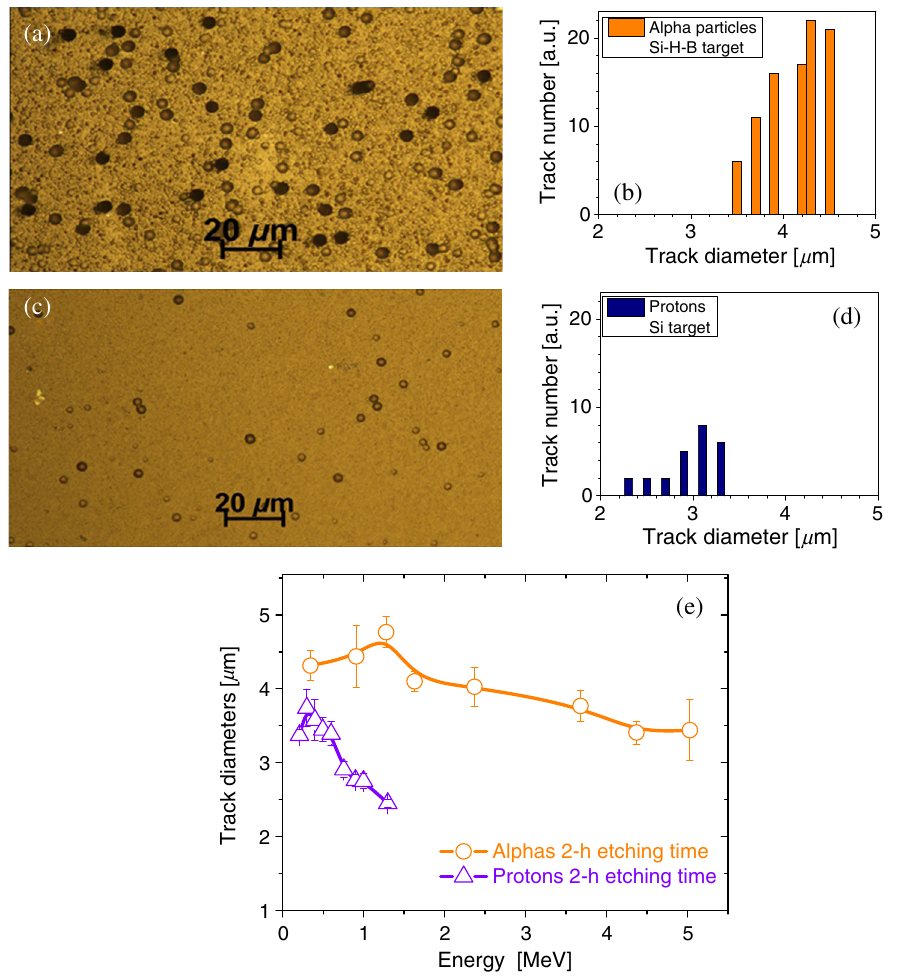
FIG. 3. PM-355 film snapshot showing craters produced by incident protons (small light craters) and alpha particles (large black craters) for (a) the Si-H-B target and (b) the corresponding histograms of particle crater diameters. (c) The PM-355 snapshot shows craters produced by incident protons (small light craters) for the Si target and (d) corresponding histograms of particle crater diameters. (e) The PM-355 calibration curve for alpha particles and protons after 2-h etching time. An Al foil of 15 μ m in thickness is placed in front of the PM-355